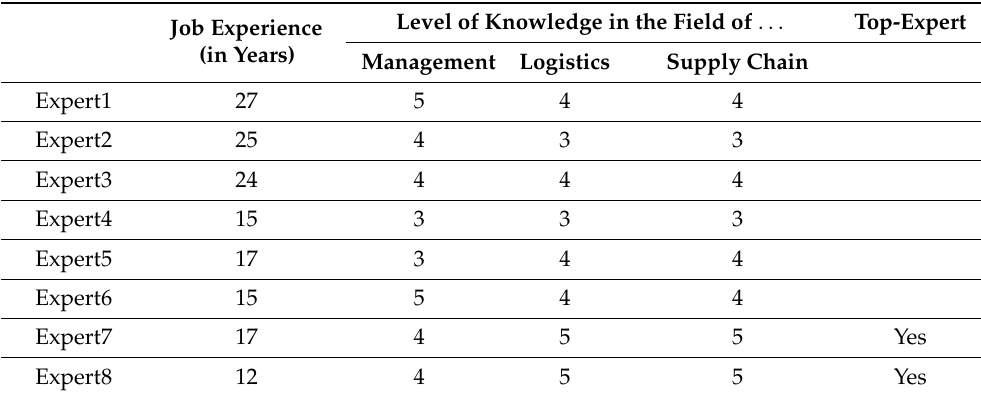
Table 1. Demographics Focused Interview participants.